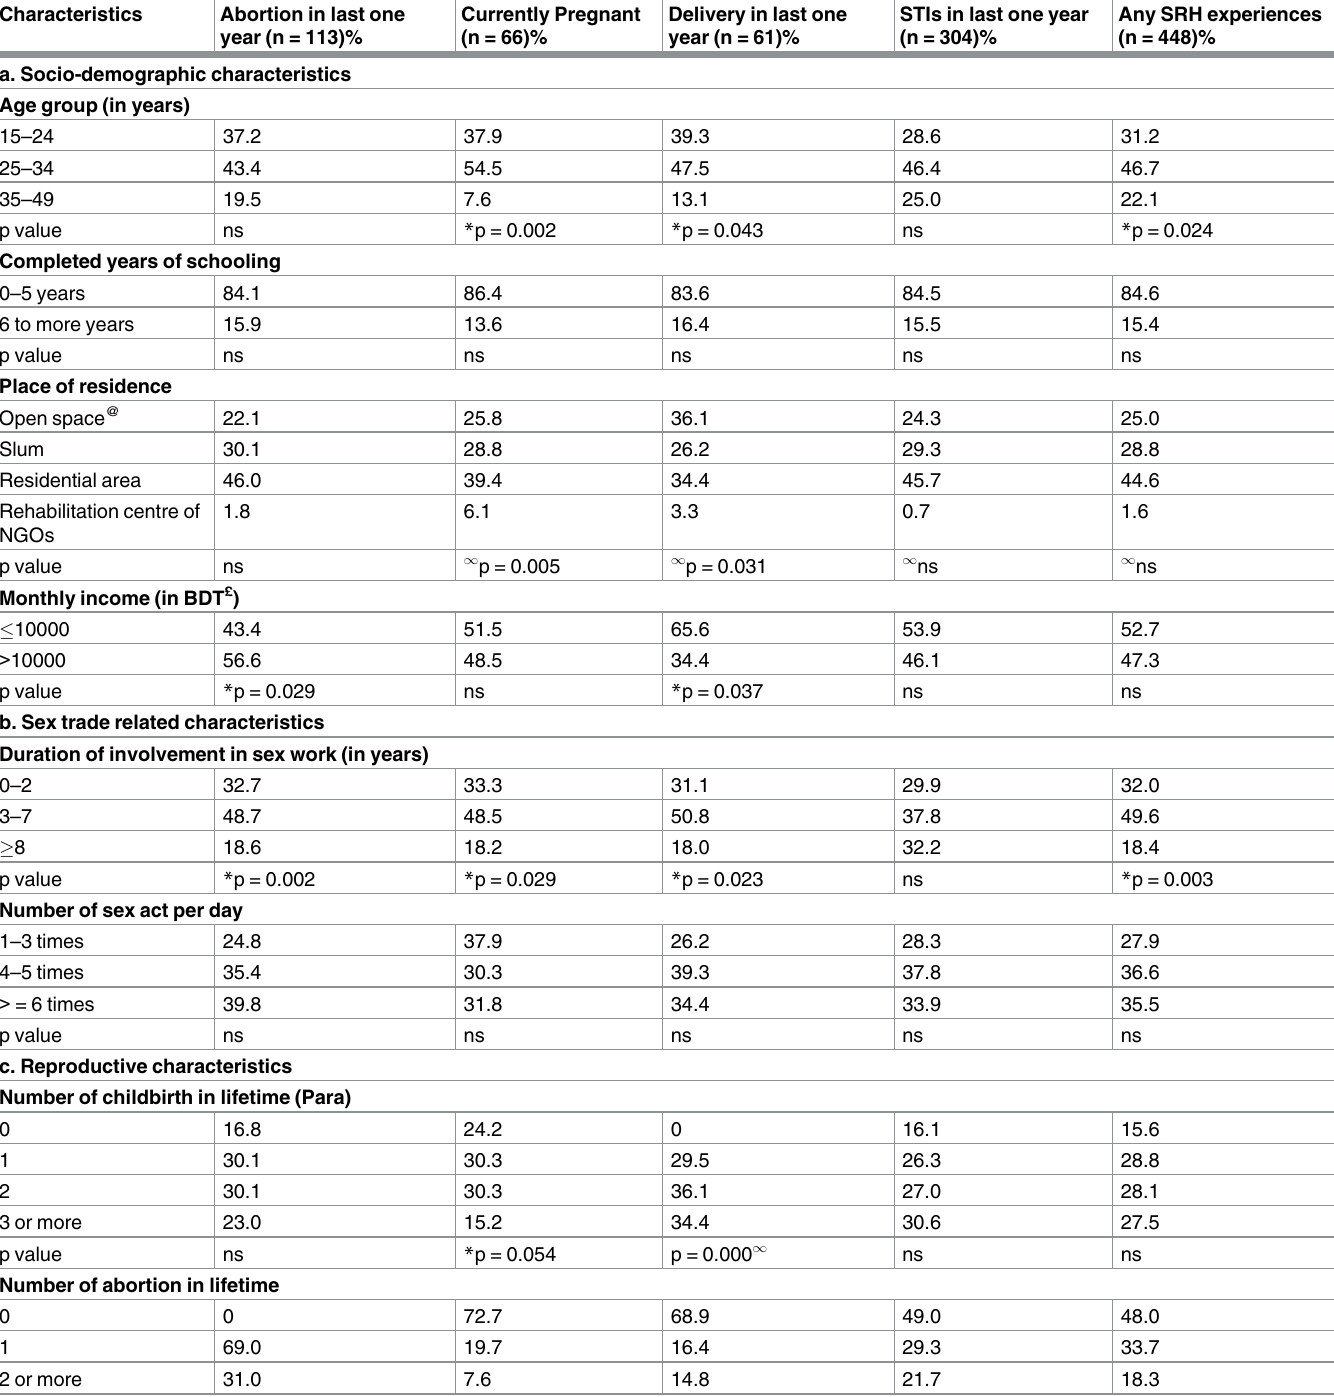
Table 2. Socio-demographic characteristics by type of SRH-related experiences(n = 731).